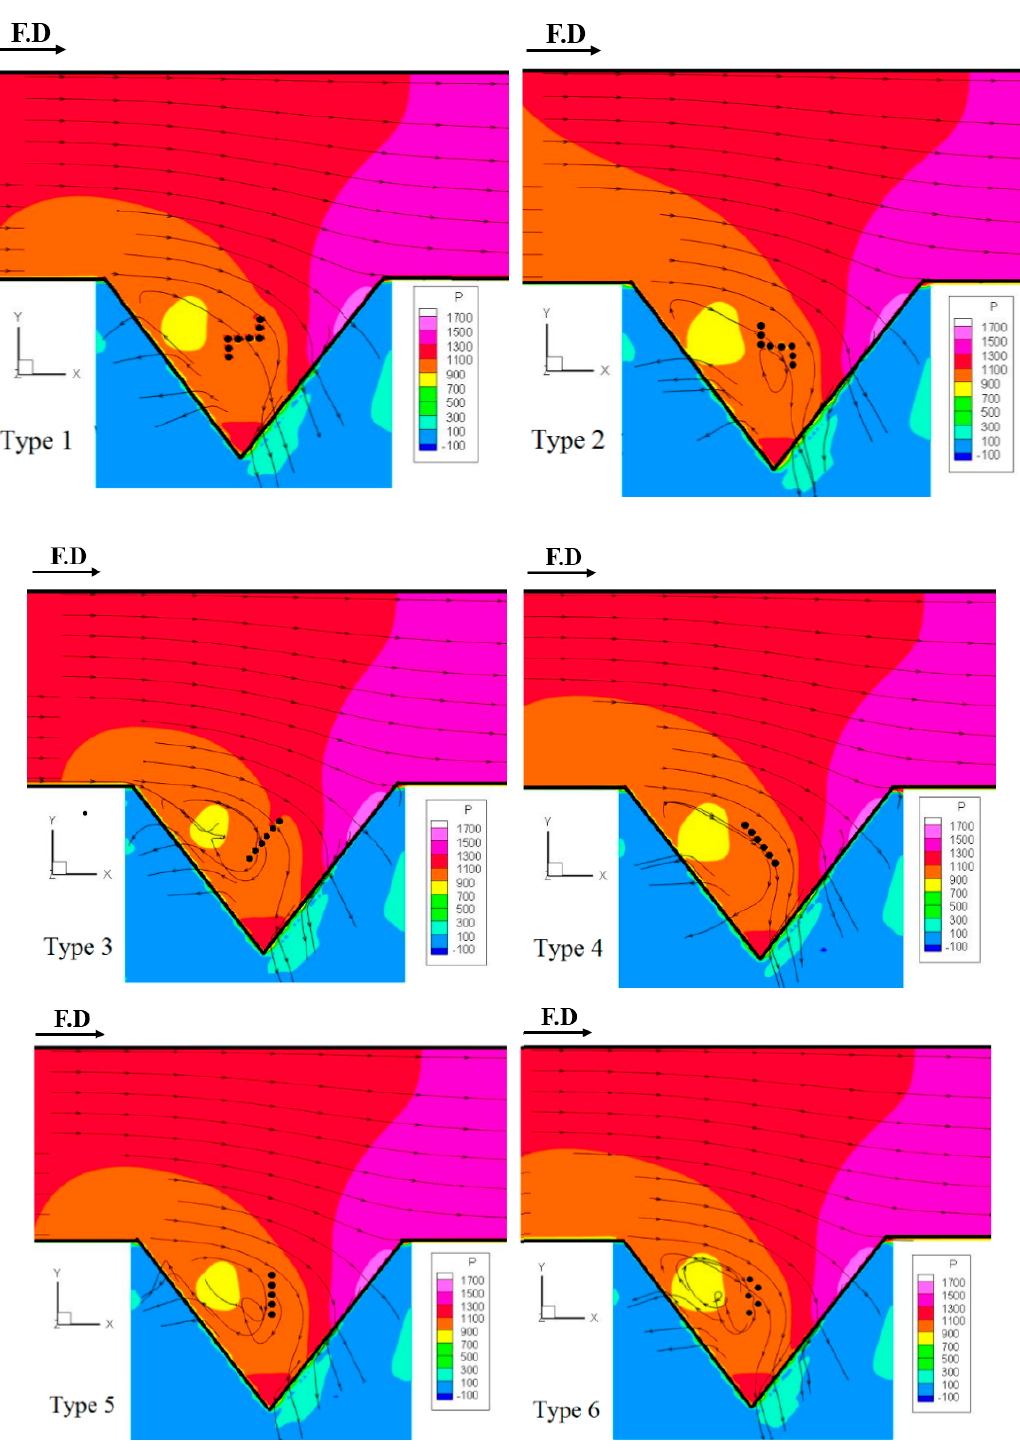
Figure 16. Pressure over the side weir and around the different antivortex structures.